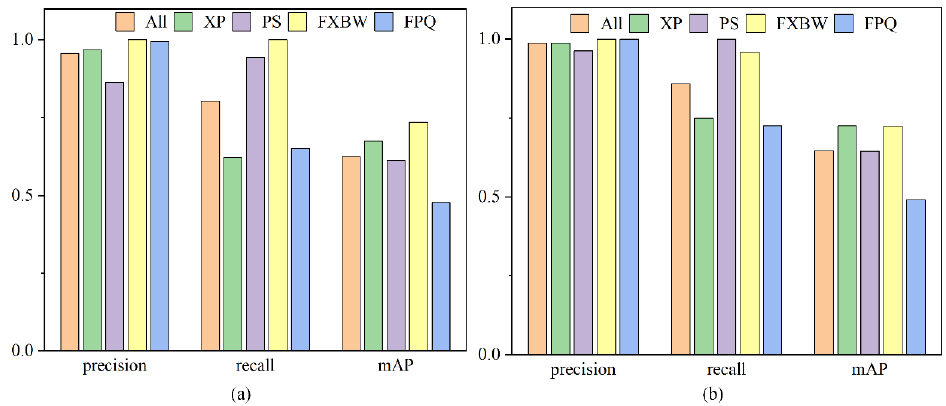
Figure 22. Comparison of recognition accuracy. ( a ) YOLOv5; ( b ) depth-attention YOLOv5.